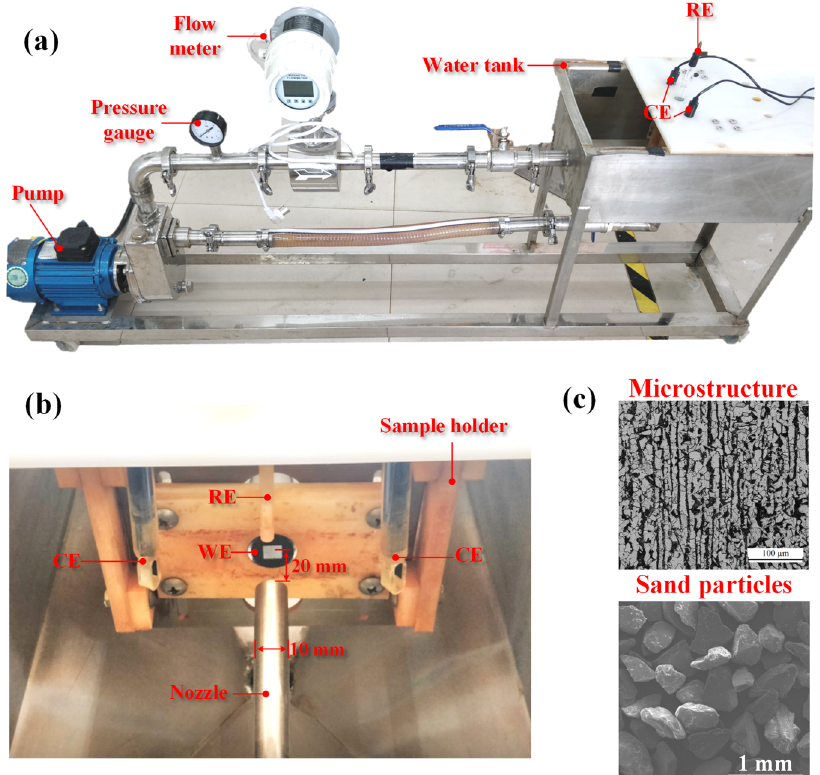
Fig. 11 The jet impingement test setup used for erosion − corrosion experiments and the test materials. a The submerged impingement jet system. b The internal view of the water tank. c The microstructure of the EH 32 carbon steel and the shape of the sand